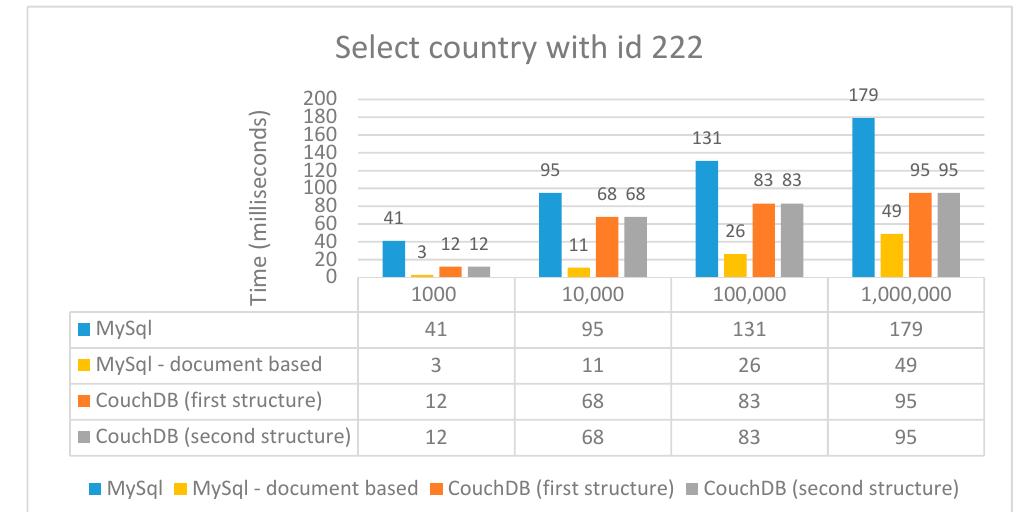
Figure 7. Performance time (ms) for the simple select operation.